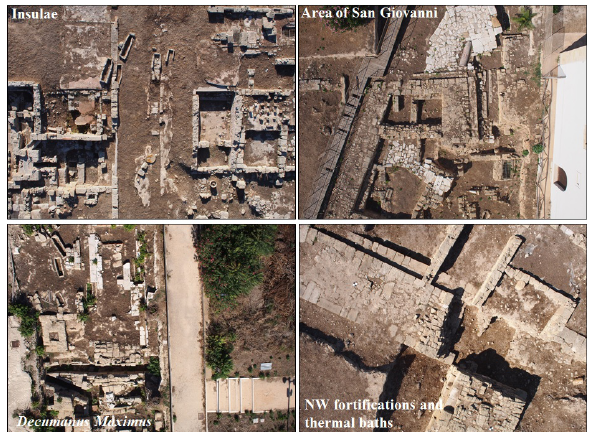
Figure 8. UAV nadiral images of the Insulae , the Decumanus maximus , the area of “San Giovanni” and the area of north- western fortifications and thermal